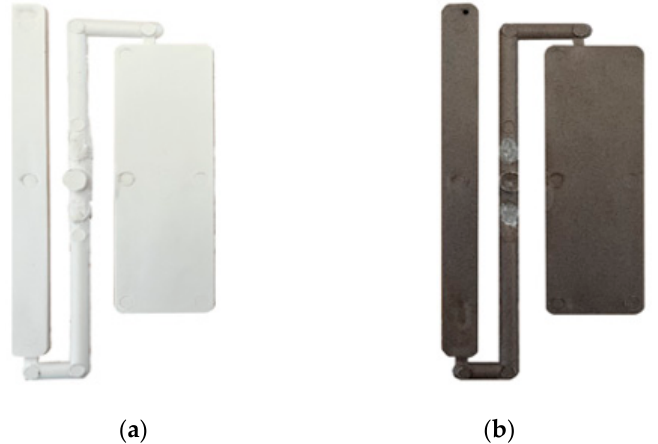
Figure 3. Injection molding samples: ( a ) MB; ( b ) MB/HS 10% .